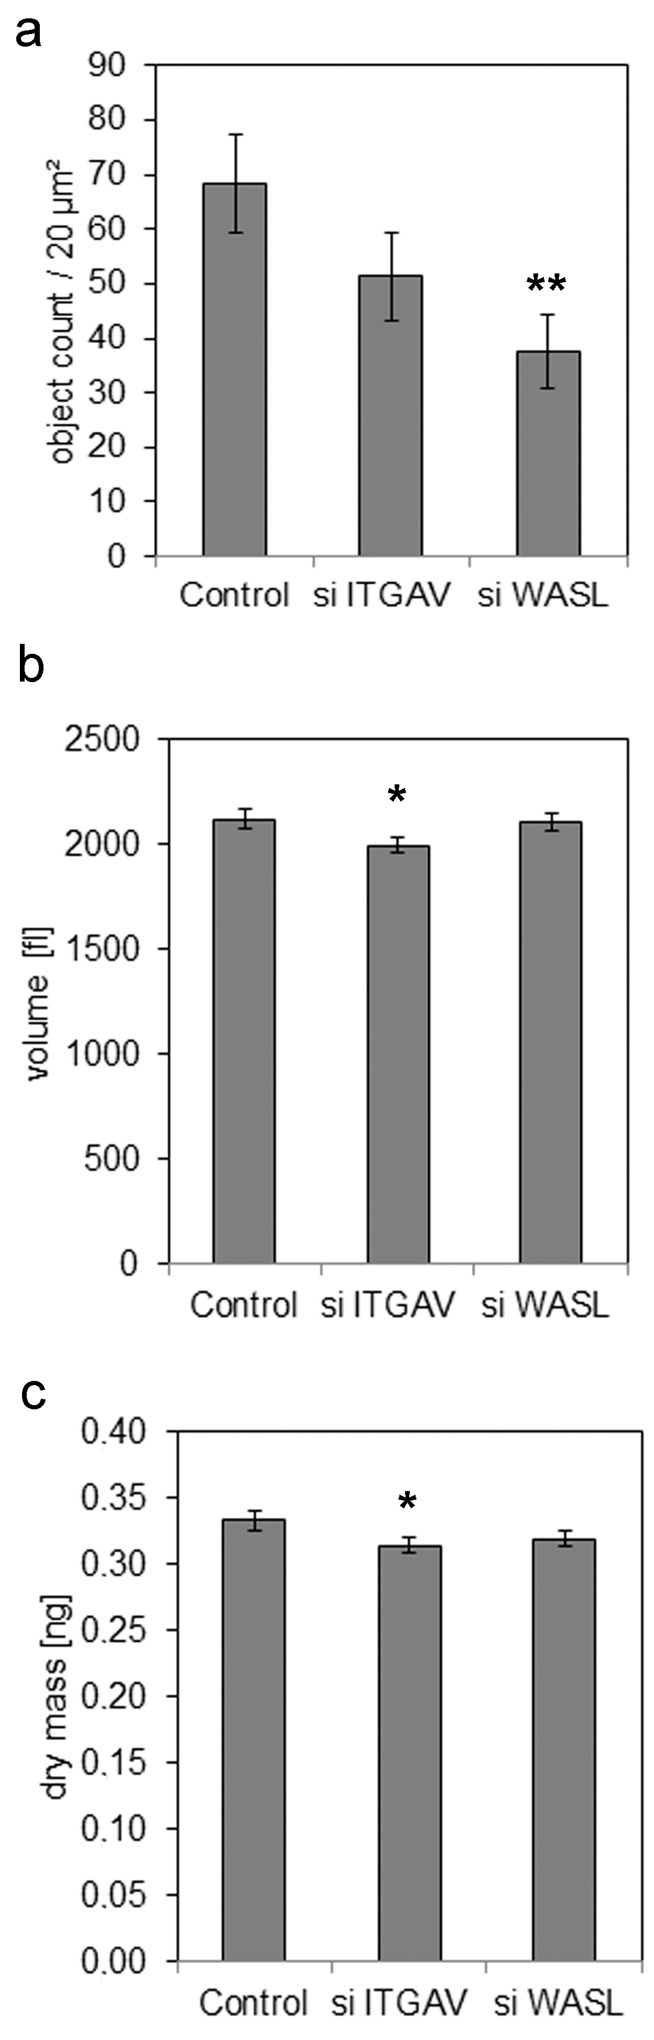
siRNA-mediated depletion of WASL or ITGAV differentially affect membrane protrusions, cell volume and dry mass of MDA-MB-468 cells.MDA-MB-468 cells were subjected to control, ITGAV or WASL siRNA treatment, followed by analysis via AFM (a) or DHM (b,c), 72h after transfection. (a) MDA-MB-468 cell surfaces were imaged by Atomic Force Microscopy (AFM) at nanometer resolution. Quantitative analysis of object counts as a readout of membrane protrusion formation reveals a significant reduction in cells treated with WASL siRNA (** = p<0.01, n = 15, error bars = s.e.m.). (b,c) Digital holographic microscopy of siRNA transfected MDA-MB-468 cells reveals decreased cell volume (b) and dry mass (c) after ITGAV siRNA transfection compared to control siRNA-transfected cells. *P<0.05, N = 200 cells per group, data are mean ± SEM.